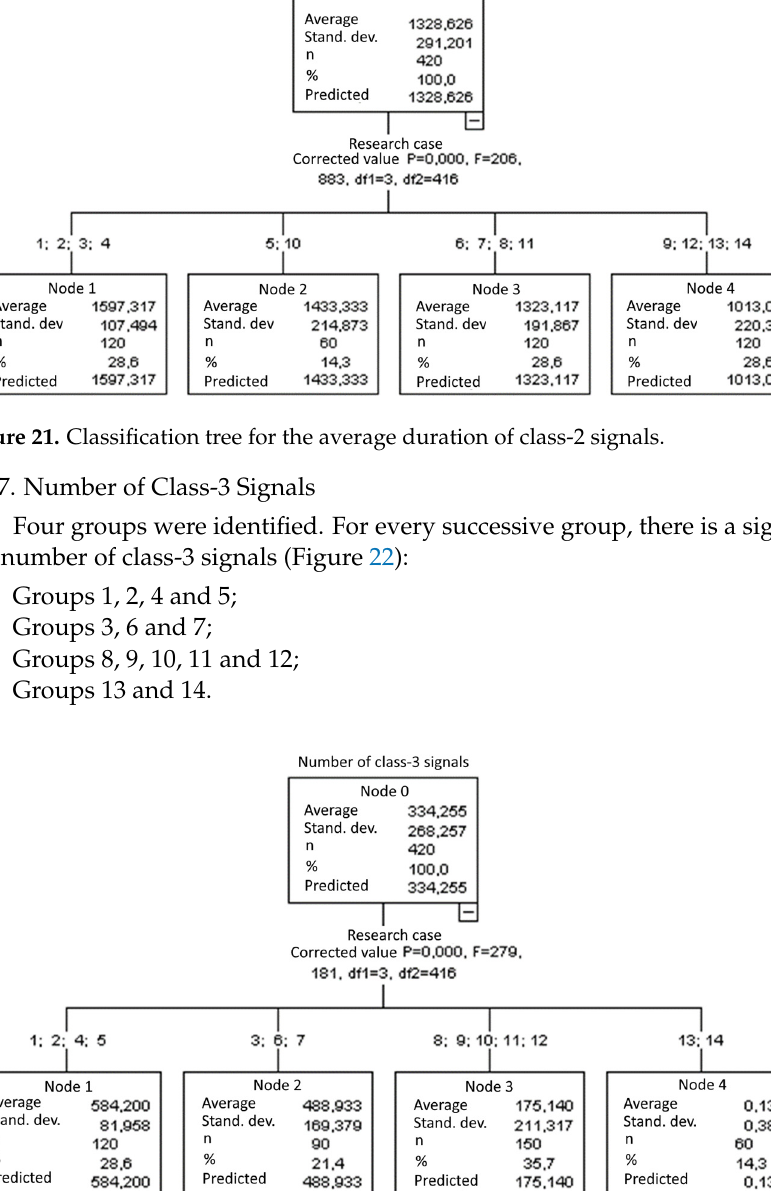
Figure 23. Classification tree for the average strength of class-3 signals.